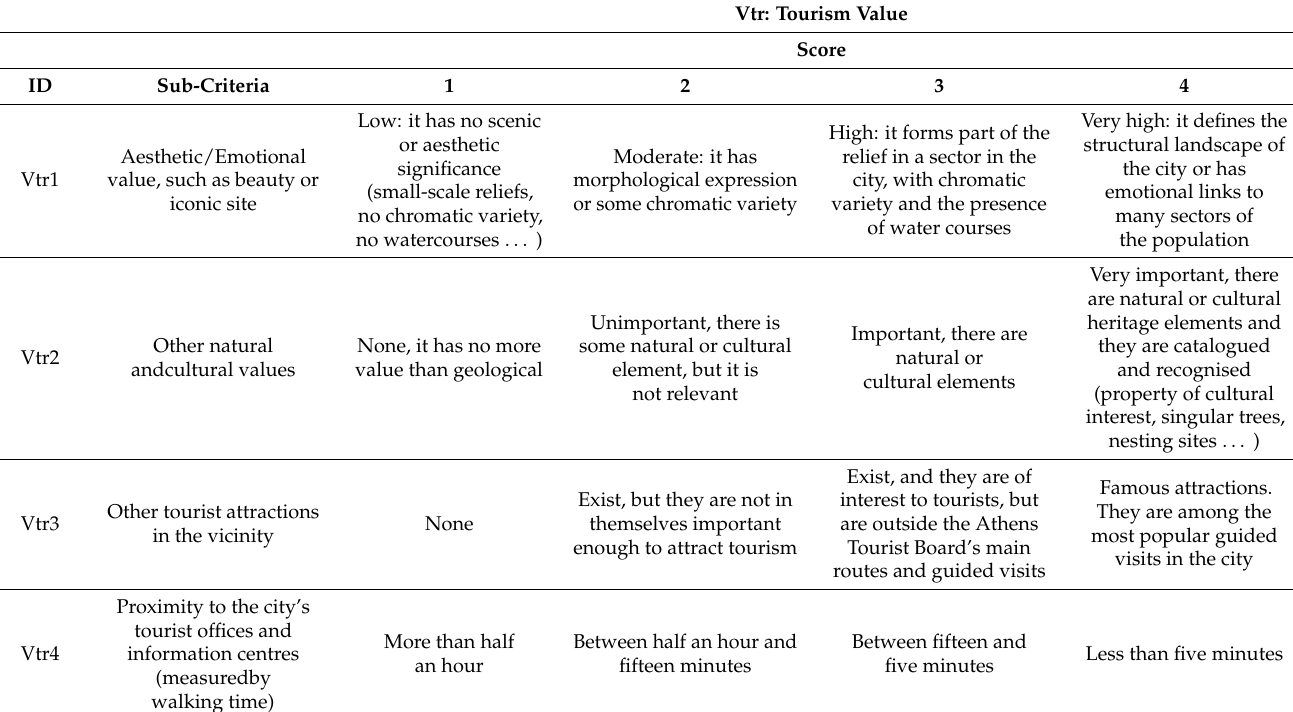
Table 3. Tourism value and sub-criteria [64,65] (modified by